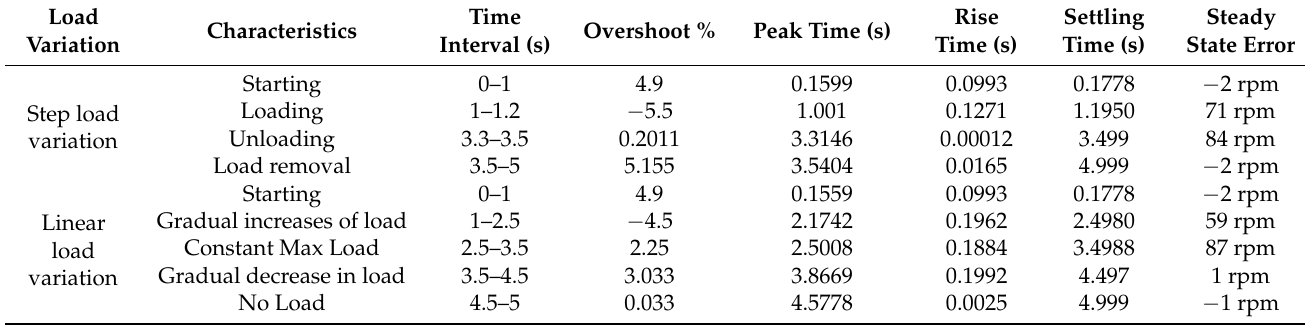
Figure 8. Transient performance of the drive with fuzzy-PI controller. Table 4. Fuzzy-PI Controller